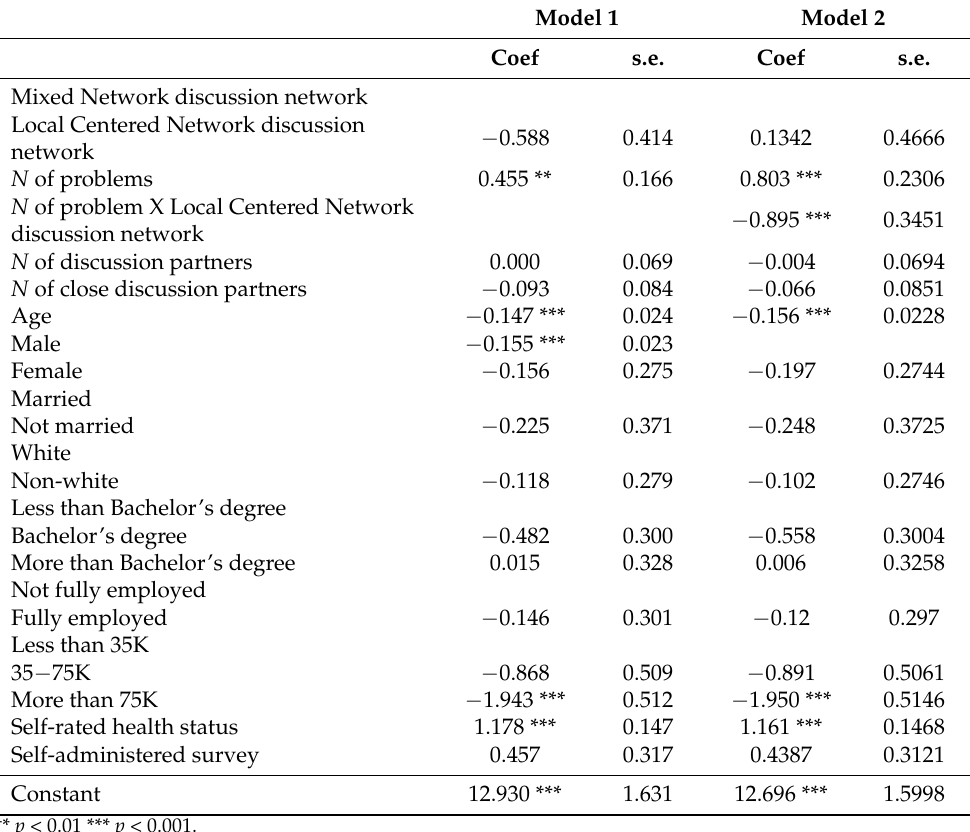
Table A4. Effects of discussion network types on depression symptoms: full